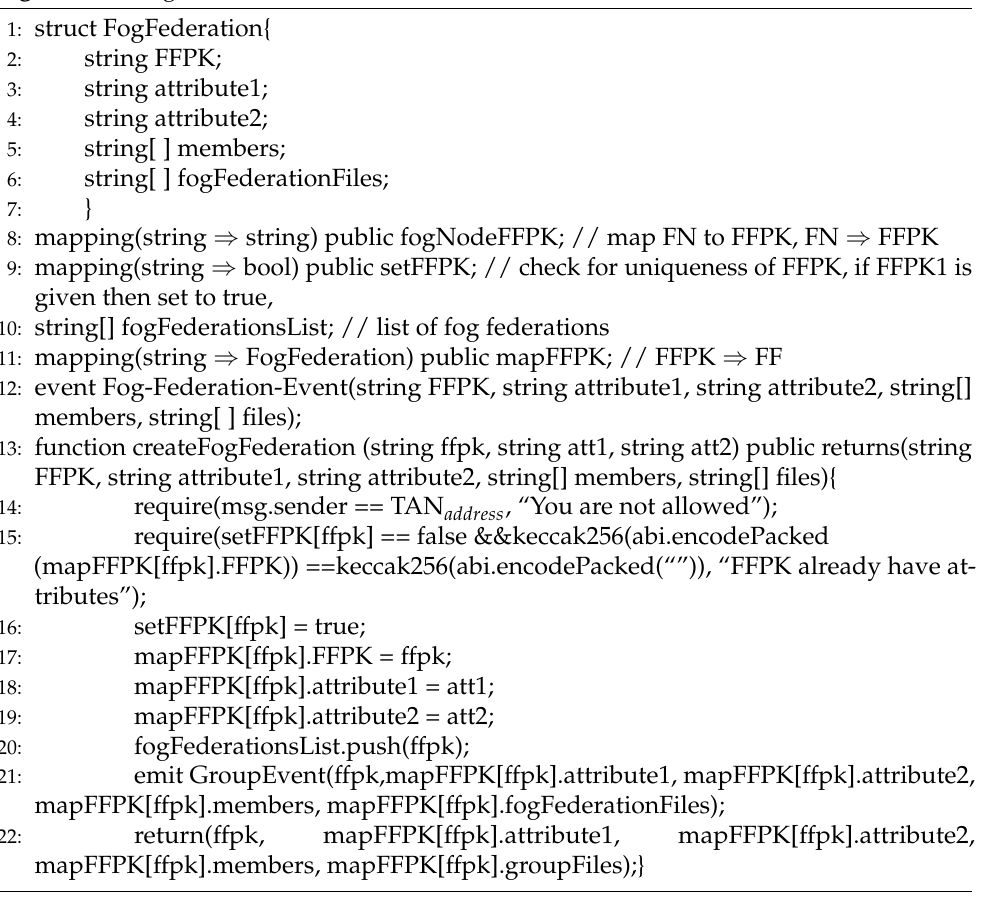
Algorithm 6 Fog federation creation smart